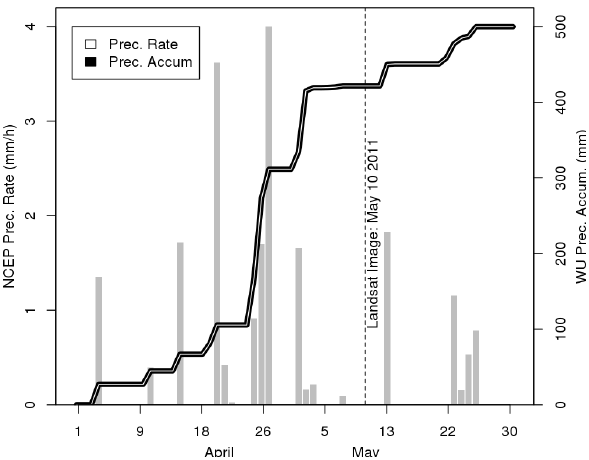
Figure 2: Maximum daily precipitation rate and and accumulated precipitation for the period ranging from 1 April to 31 May 2011.